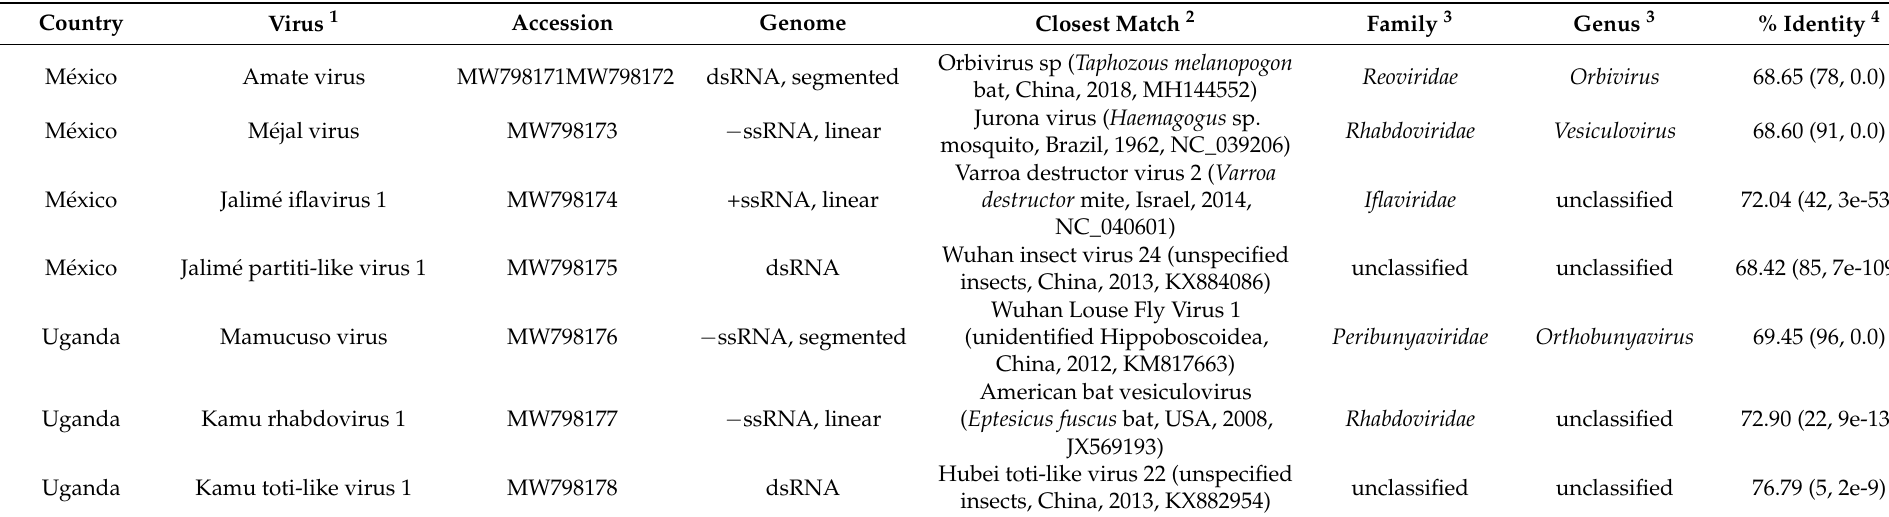
Table 1. Viruses identified in streblid bat flies from M é xico and